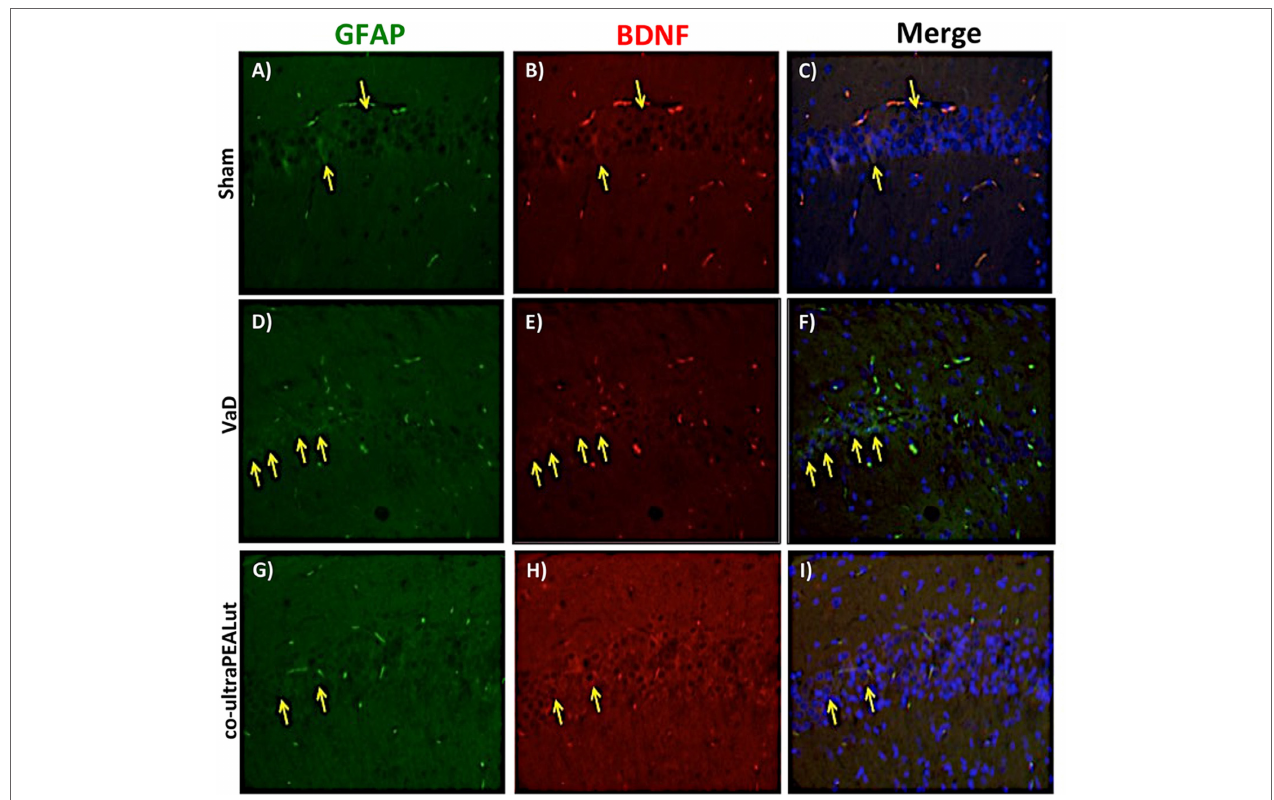
FigUre 9 | co-localization of gFaP/brain-derived neurotrophic factor (BDnF) after carotid arteries occlusion . Results are shown for Sham group (a–c) , mice after carotid arteries occlusion (D–F) , mice treated with co-ultraPEALut (g–i) . Brain sections were double stained with antibodies against GFAP [ (a,D,g) , green], and BDNF [ (B,e,h) , red]. Hippocampal area revealed increased astrogliosis (D) in VaD group. GFAP immunoreactivity was reduced in co-ultraPEALut-treated mice (g) . Yellow spots indicate co-localizations and revealed a high co-localization between GFAP/BDNF double staining (c,F,i) . The pictures are demonstrative of at least three experiments executed on distinctive experimental days. Images are representative of all the animals in every group. All pictures were digitalized at a resolution of 8 bits into an array of 2,048 × 2,048